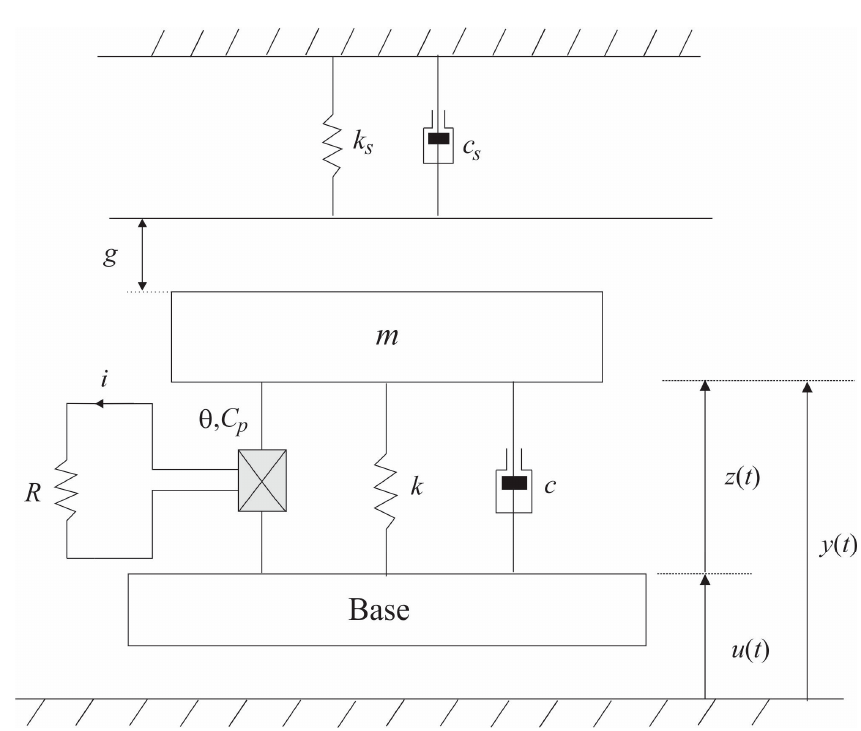
Figure 1. Archetypal model of a vibration-based energy harvesting system with discontinuous support.